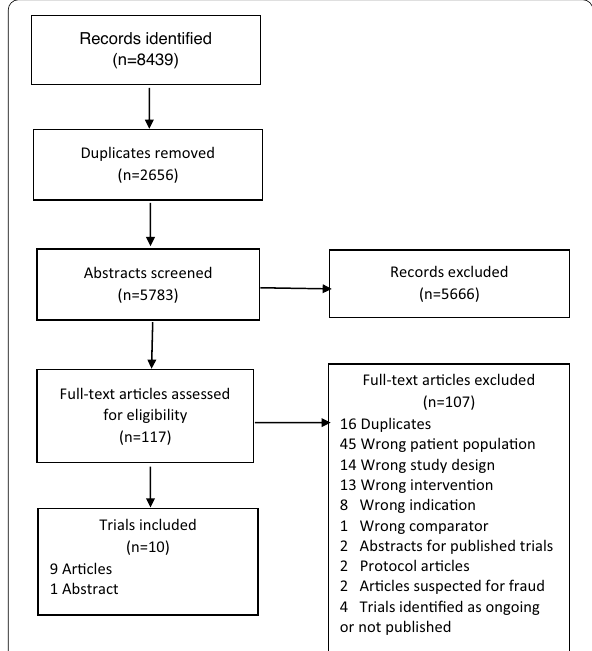
Fig. 1 Preferred reporting items for systematic reviews and meta-analyses (PRISMA) flow